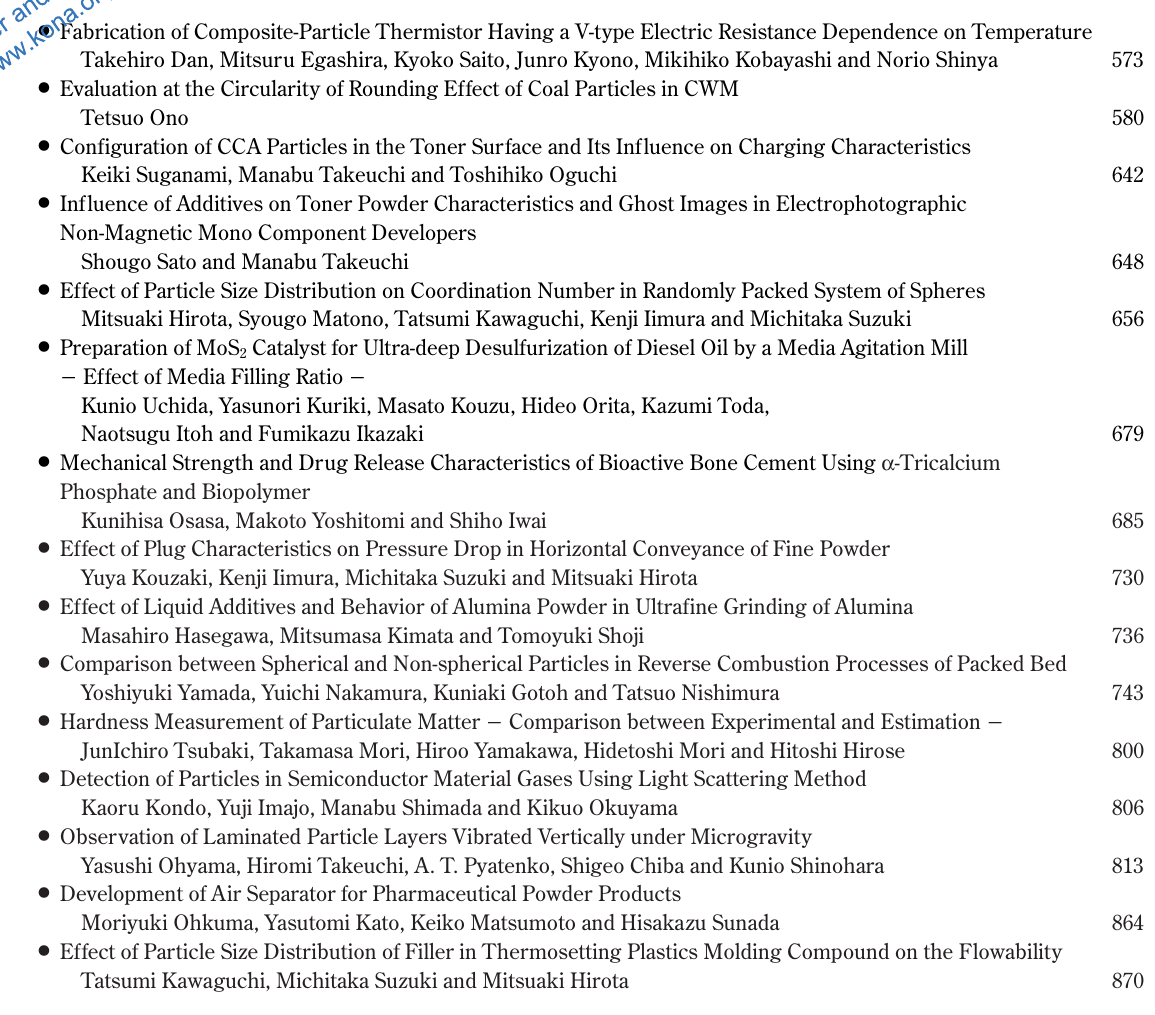
573 580 642 648 656 685 730 736 743 800 806 813 864